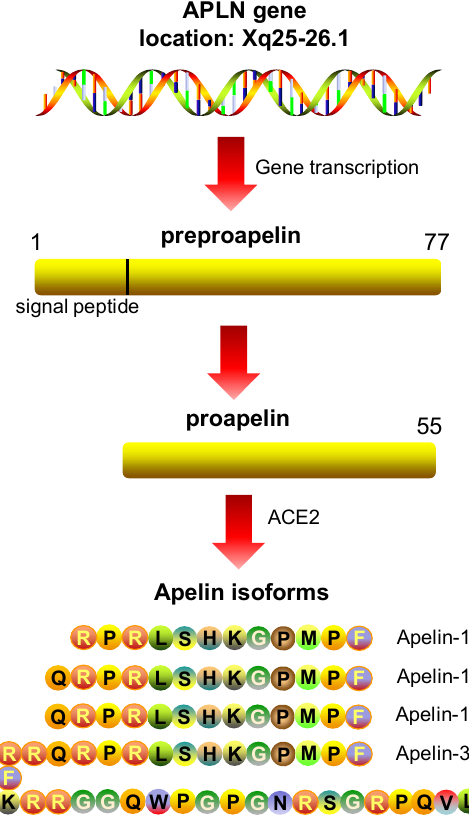
Figure 4. Apelin peptide isoforms.